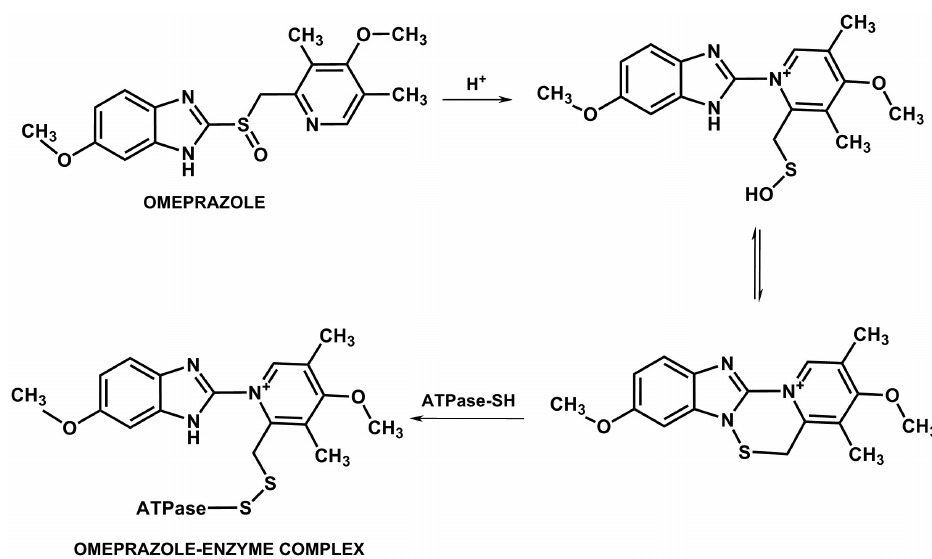
FIGURE 12 - Omeprazole activation mechanism and sequential inhibition of gastric H + /K + ATPase.